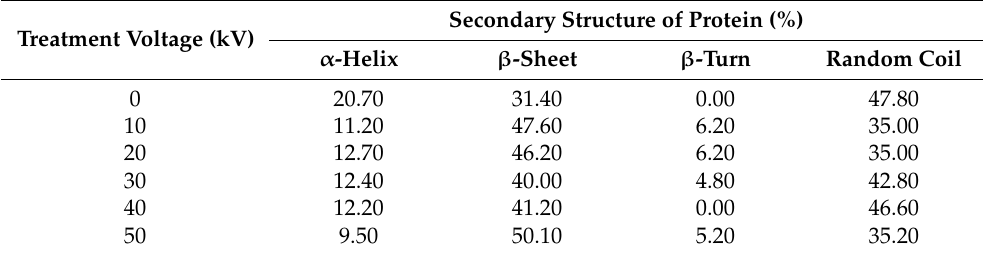
Table 5. Effect of different ACP treatment voltage on the secondary structure of